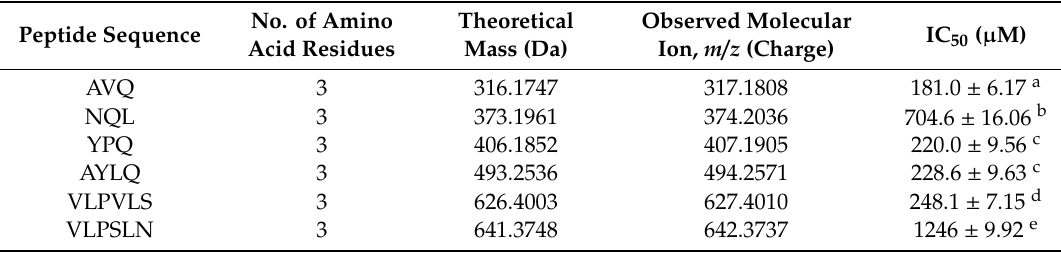
Table 4. Information of identified peptides and the concentration inducing 50% inhibition (IC 50 ) for ACE of corresponding synthetic peptides 1